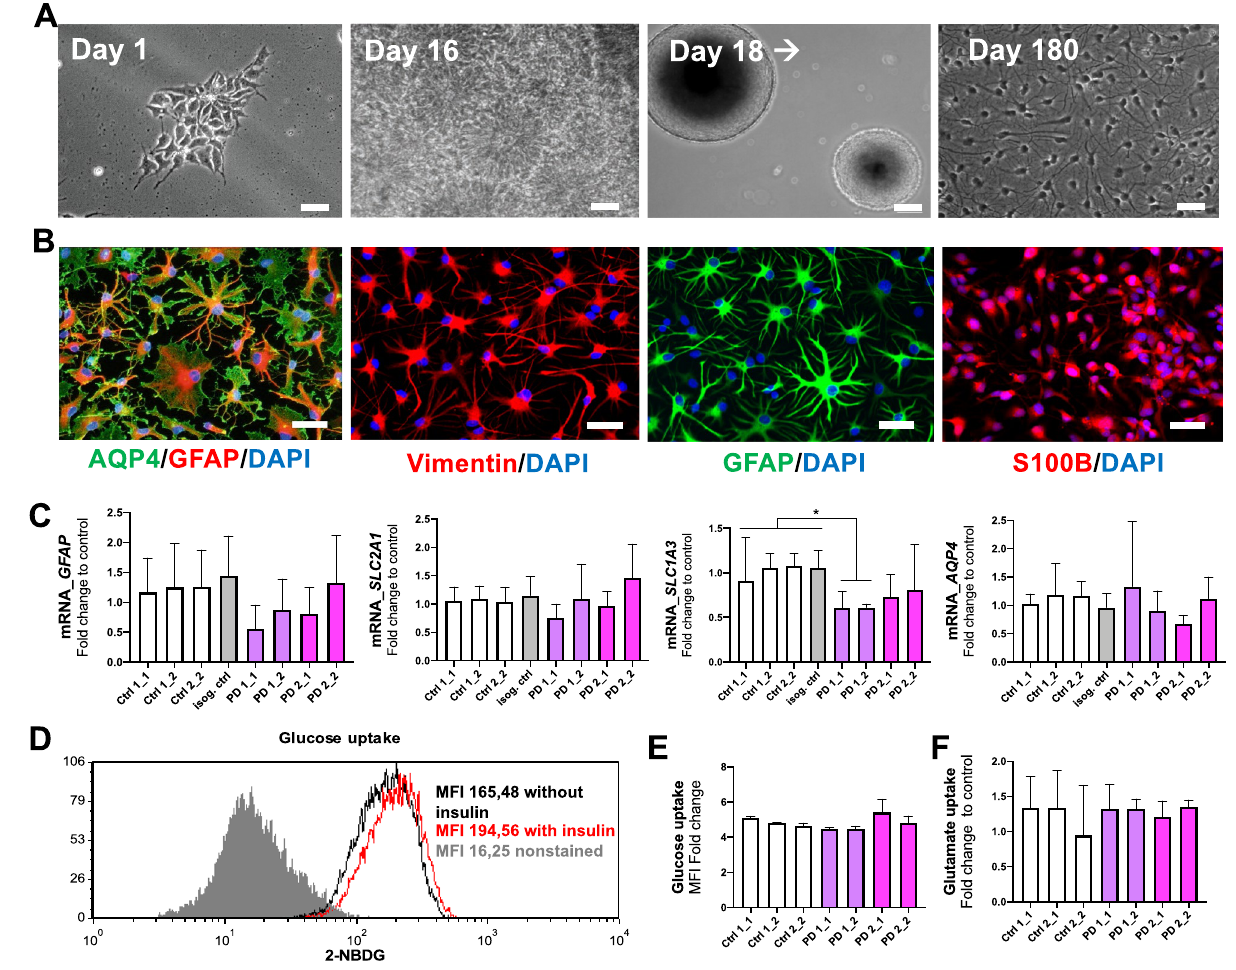
Figure 1. Differentiation and characterization of hiPSC-derived astrocytes from healthy subjects and PD patients. ( A ) Representative images from astrocyte differentiation. Bright field images showing hiPSCs at day 1, the rosettes at day 16, progenitor cells expanded as spheres from day 18 onwards and matured astrocytes at day 180. ( B ) Representative fluorescence images of astrocytes matured for 7 days and stained for AQP4, Vimentin, GFAP and S100B. Nuclei are stained with DAPI. Scale bars, 50 µm. ( C ) Relative gene expression levels GFAP, SLC2A1, SLC1A3 and AQP4 in astrocytes shown as fold change from healthy control. ( D ) Representative FACS histogram of glucose uptake analysed by fluorescent glucose analog 2-NBDG. Grey area shows untreated cells, black line shows cells incubated with 2-NBDG and red line shows cells incubated with insulin and 2-NBDG. ( E ) Glucose uptake analyzed by fluorescent glucose analog 2-NBDG. ( F ) Glutamate uptake measured with radiolabeled glutamic acid. Three independent experiments. Bars represents mean ± SD, *p < 0.05. PD1 patient carries a mutation in LRRK2 (G2019S) and GBA (N370S), PD2 patient carries a mutation in LRRK2 (G2019S) and isogenic control for PD2